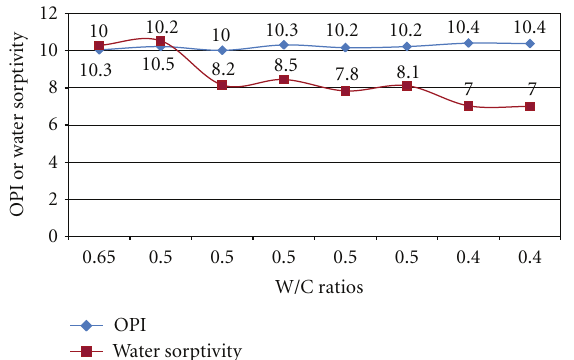
Figure 4: OPI and water sorptivity for CEM II/A-M (V-L) 42.5N at di ff erent w/c ratios.